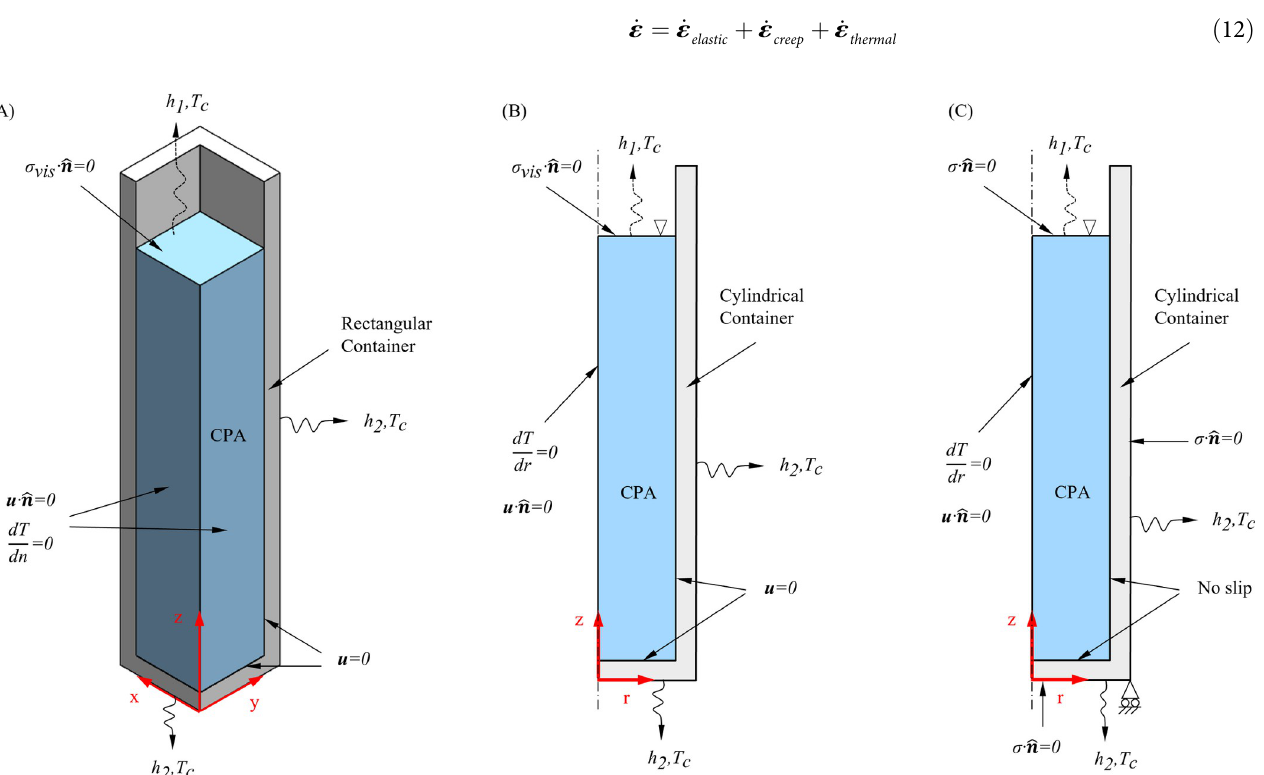
PLOS ONE | https://doi.org/10.1371/journal.pone.0282613 March 9,